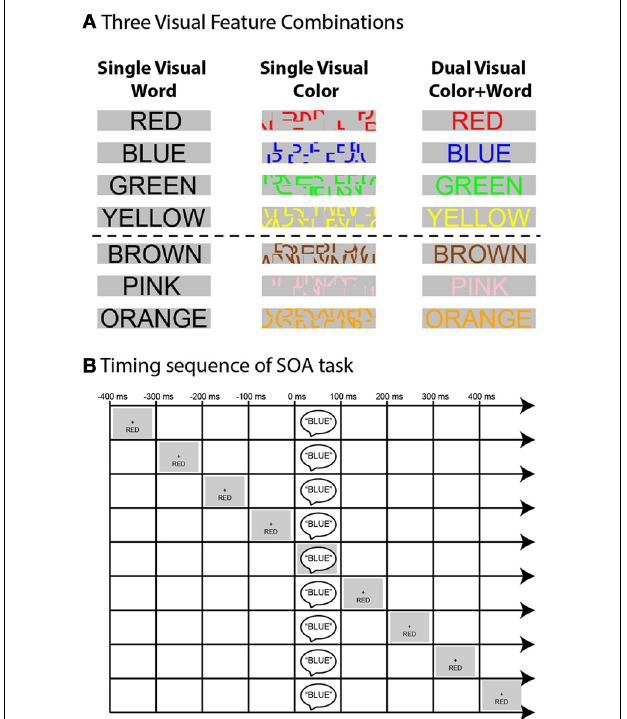
FIGURE 1 | (A) Schematic depiction of the visual feature combinations used in the three tasks. The top four rows show visual stimulus component of the words that were used as targets (i.e., mapped to a response) while the bottom three rows show the neutral words (i.e., those not mapped to a response). (B) Schematic of SOA timing sequence. Example shown is that of an incongruent trial in the Single Visual Word task for the auditory attention condition wherein participants were instructed to report the auditory stimulus component (spoken-word “BLUE”) while ignoring the visual stimulus component (in this case the word “RED,” presented visually below fixation). The irrelevant visual information could come before or after the target in increments of 100ms out to − 400 and +